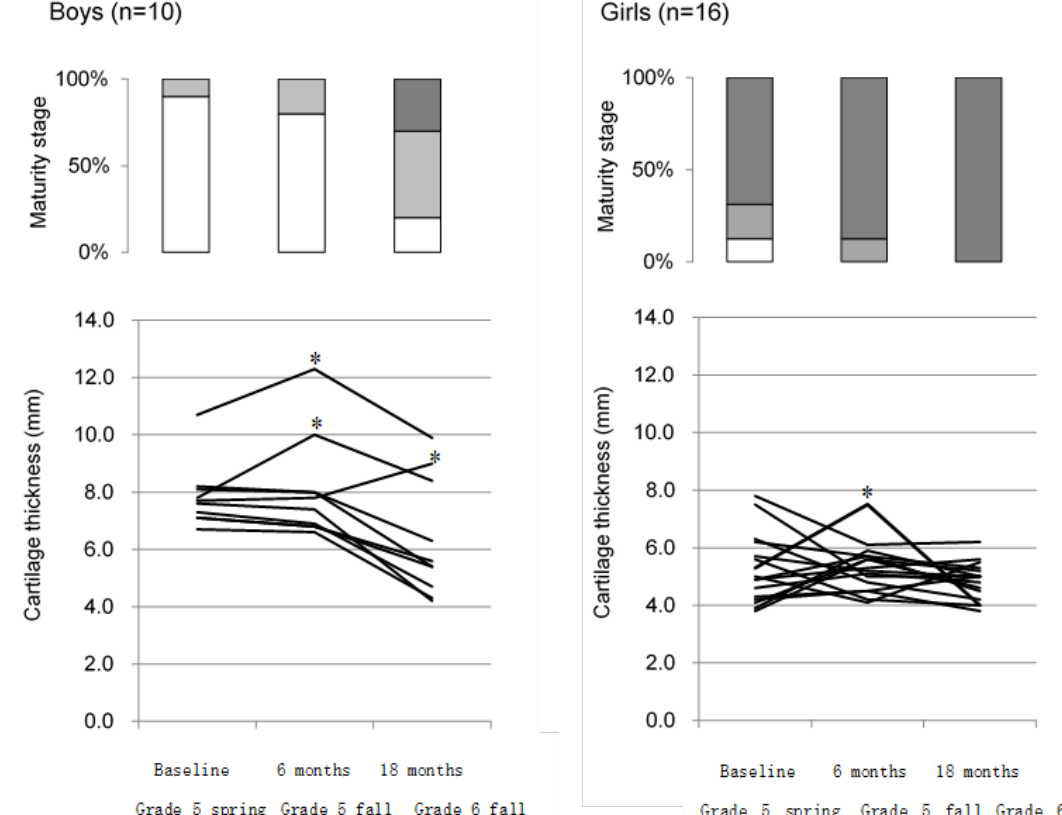
Figure 3. Percentage of students in each maturity stage and changes in cartilage thickness of each student at each examination time point from the longitudinal survey of grade 5 students ( n = 26) by sex. Maturity stage (upper panel); Cartilaginous stage , Apophyseal stage , Epiphyseal stage * Measurement points showing ≥20% consecutive increases in cartilage thickness from the previous measurement during observation. A girl who showed ≥20% consecutive increases in cartilage thickness in grade 5 fall developed OSD.